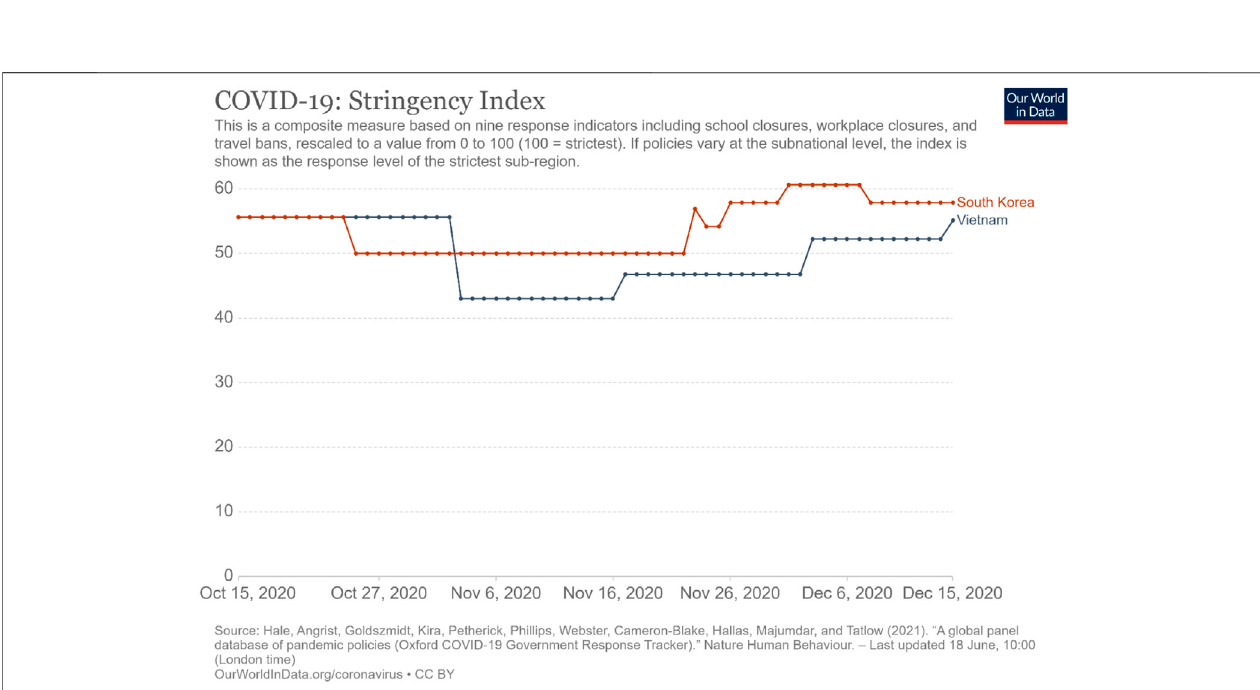
FIGURE 2 | COVID-19 stringency index in Vietnam and the RoK, as of 18 June 2021 (see Ritchie, et al., 2020).